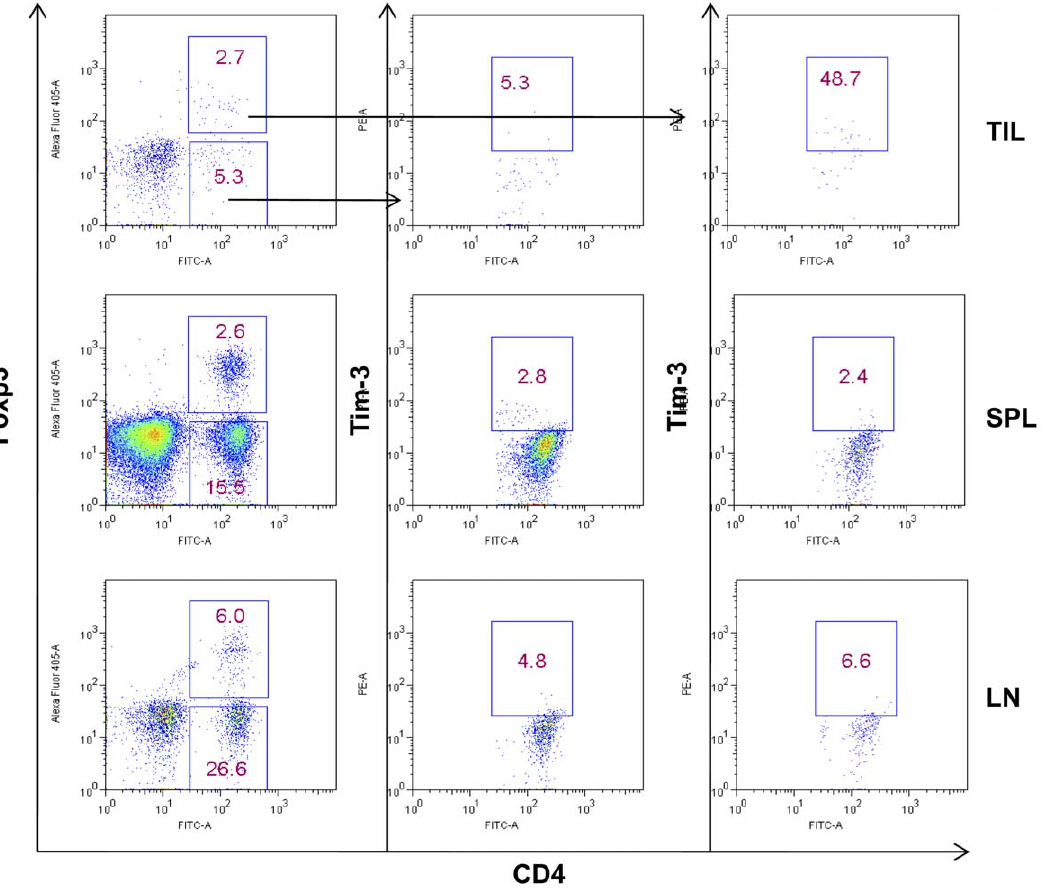
Figure 5. Expression of Tim-3 on TILs in mouse model of transplantable tumor. 6–8-week-old C57BL/6 mice were inoculated with 2 6 10 5 B16F0 cells i.d., tumor samples, spleens, and lymph nodes were removed when tumor sizes reached around 15 mm in diameters on day 20. TILs, splenocytes, and lymph node cells were isolated for analysis by flow cytometry. Tim-3 expression on mouse CD4 + Foxp3 + or CD4 + Foxp3 2 T cells is shown. Data shown are representative of five independent experiments.